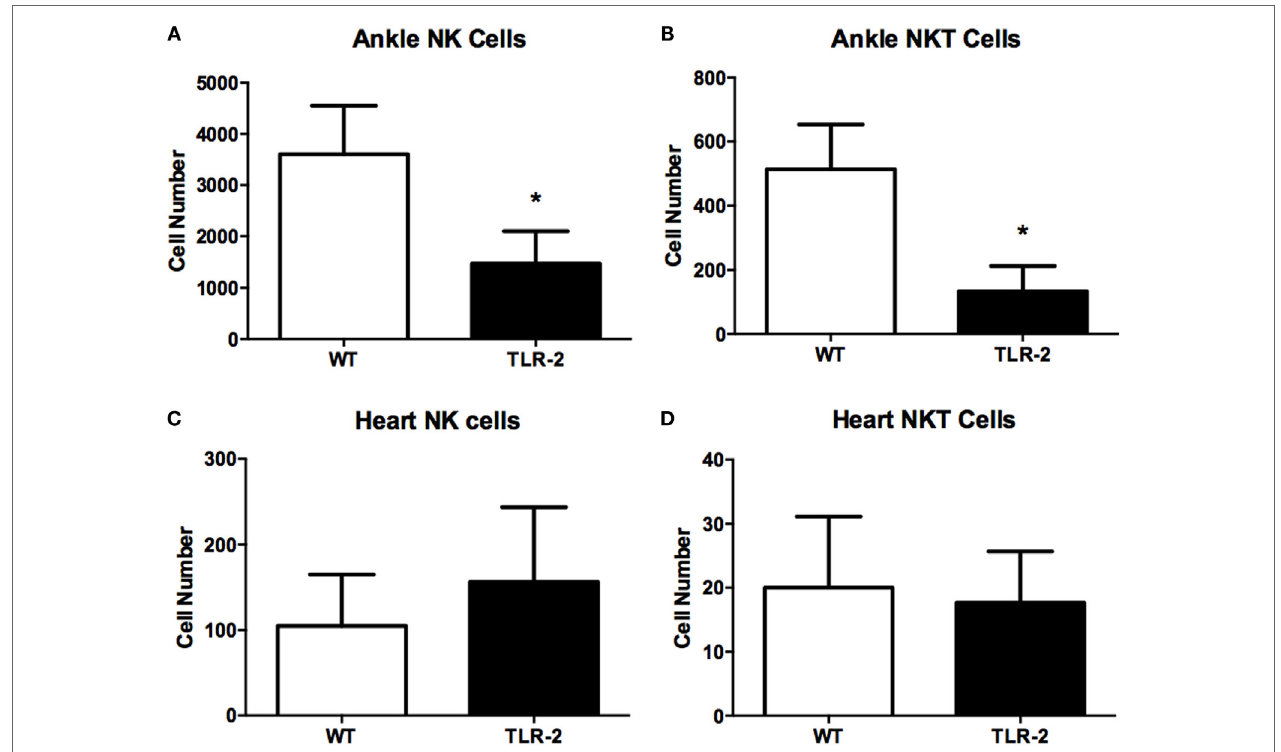
FigUre 3 | nK and nKT cells in infected ankle and heart tissue . WT and TLR2 − / − mice were infected with B. burgdorferi and three mice from each strain sacrificed at the indicated time points. NK (CD45.2 + NKp46 + CD122 + CD3e − ) and NKT (CD45.2 + NKp46 + CD122 + CD3e + ) cells were enumerated in ankle (a,B) and heart (c,D) tissue at day 21 postinfection. Data are representative of two separate experiments. Bars represent means + SD. * p > 0.05 compared to WT control from same time